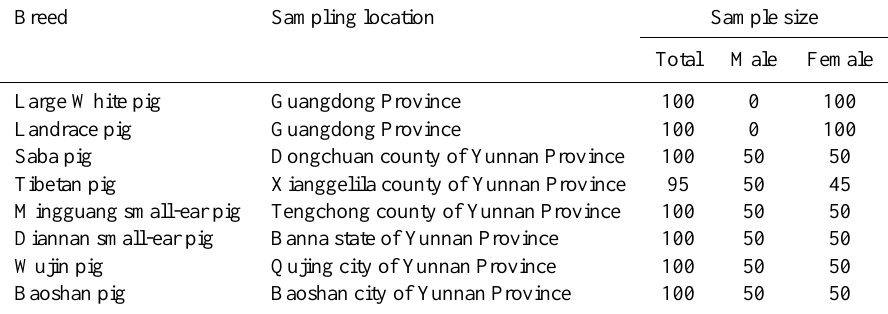
Table 1. Information of 795 unrelated pigs from eight populations.